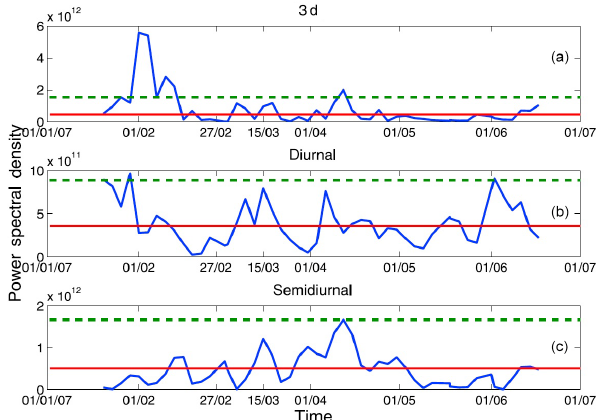
Figure 4. Power Spectral Density (PSD) of the frequencies corre- sponding to periods of (a) 3d, (b) 24h and (c) 12h of the dilatome- ter in the period January–June 2007 (blue lines). All values fall within the statistical variability except the 3d component in the pe- riod 25 January–5 February 2007, suggesting a significant devia- tion of the energy of this frequency only in this period. The red line represents the mean value of the PSD and the green line cor- responds to the mean value plus three times the standard deviation (after De Martino et al.,